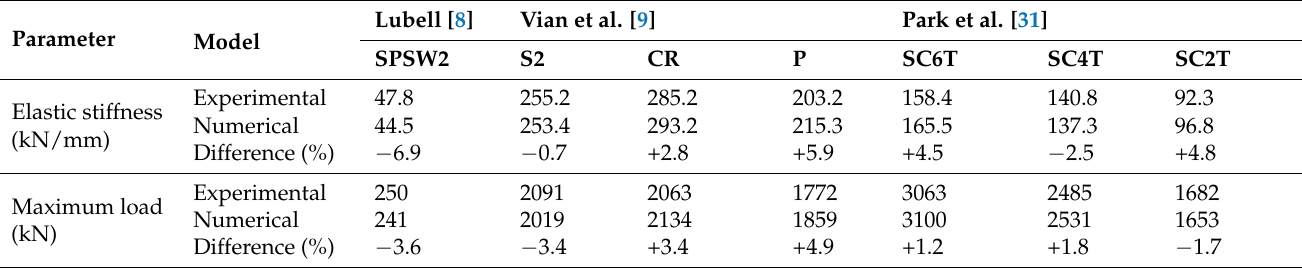
Figure 8. Comparison between numerical models (FEM) and experimental specimens (EXP): ( a ) com- parison of load–displacement curves between numerical results and test results [31], ( b ) comparison of load–displacement curves between numerical results and test results [9], and ( c ) comparison of load–displacement curves between numerical results and test results [8]. Table 3. Comparison between numerical and experimental